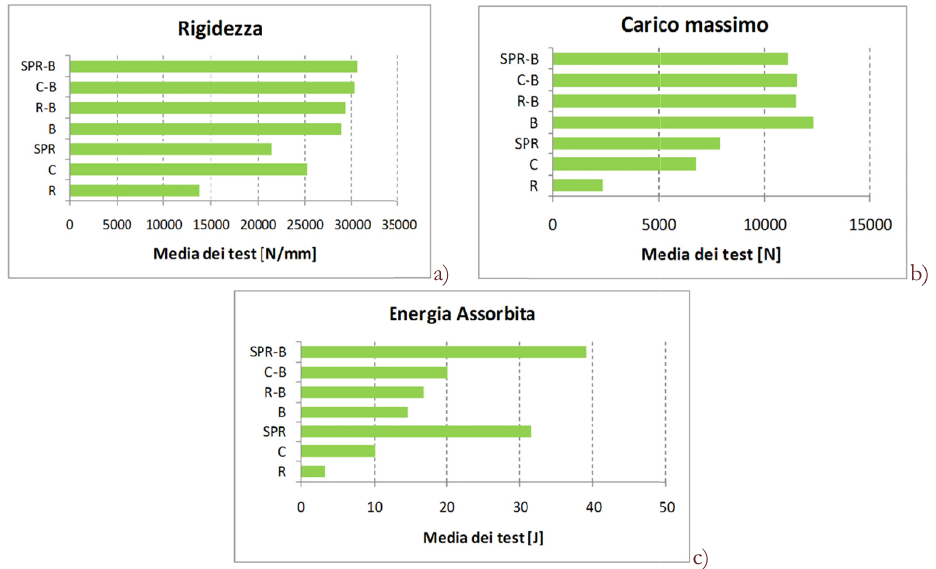
Figura 17 uesto